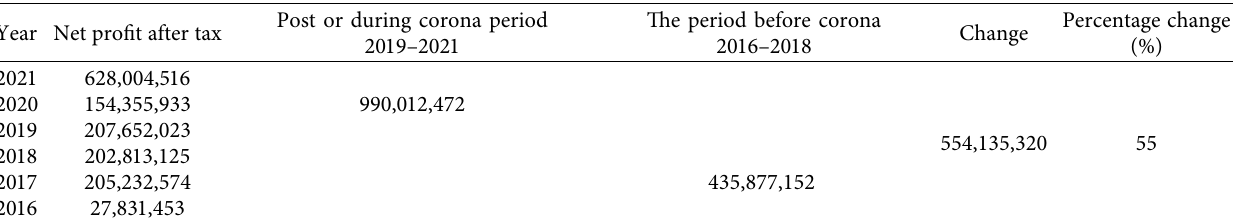
Table 3: Te development of net proft for the study sample companies before and after the efects of the Corona pandemic. Post or during corona Year Net proft after tax